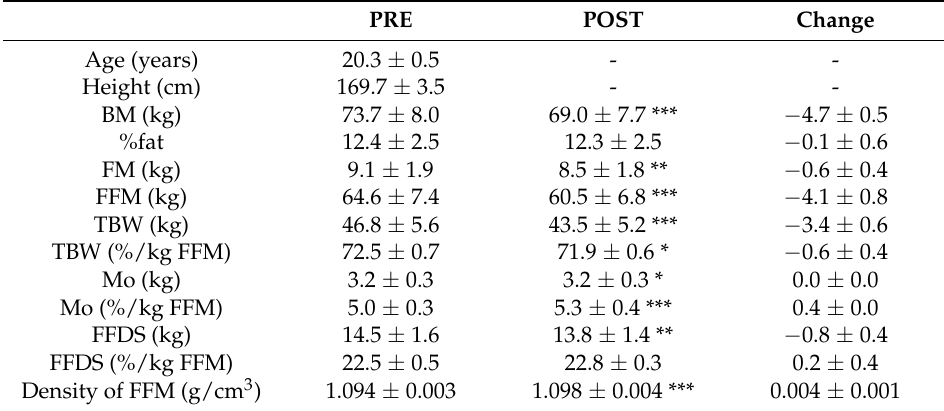
Table 1. Participant characteristics and change of body composition using the 4C model with stable isotope dilution method and DXA.